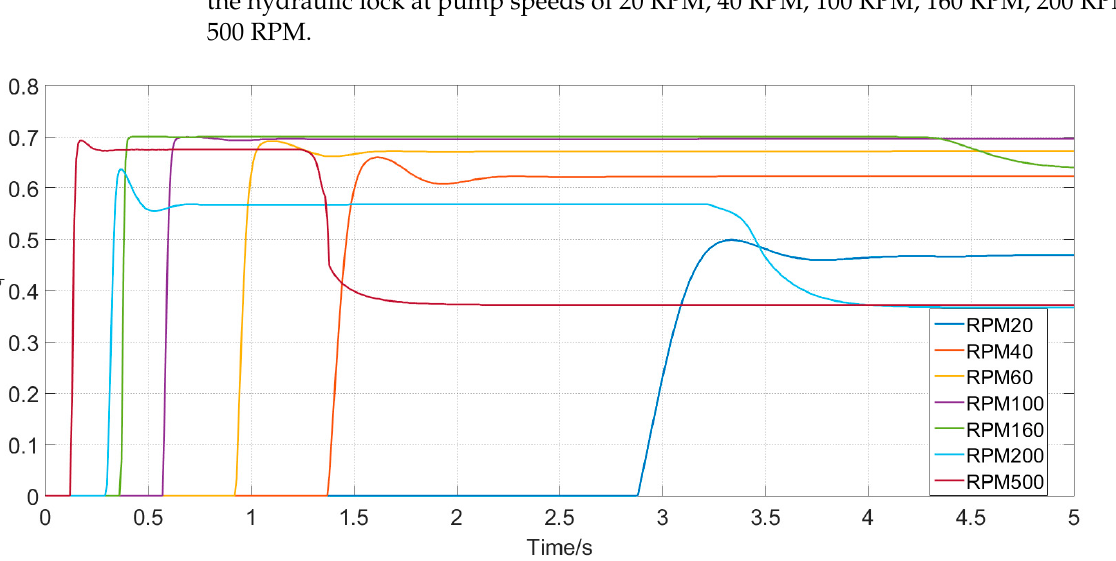
Figure 21. The flow coefficients of the hydraulic lock.